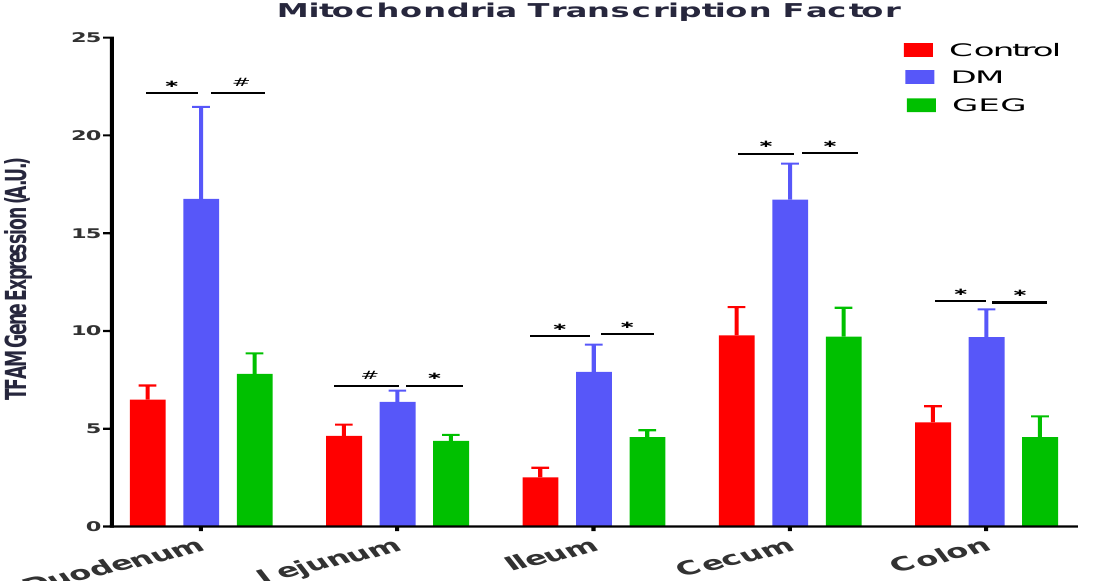
Figure 8. Effect of gingerol-enriched ginger (GEG) on mRNA gene expression of PGC1 α in duodenum, jejunum, ileum, cecum, and colon of rats. Data is expressed as mean ± SEM. n = 6 – 8 per group. Data was analyzed by one-way ANOVA followed by a post hoc Tukey’s test. * p < 0.05. # 0.05 < p < 0.1.